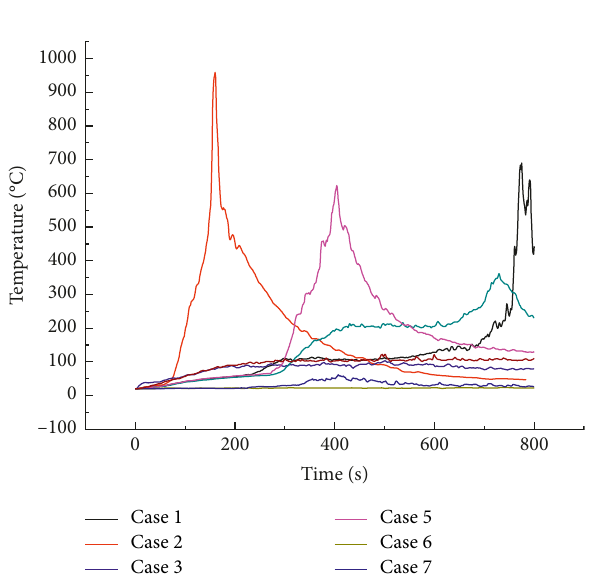
Figure 12: Comparison of maximum heat flow in eight cases.